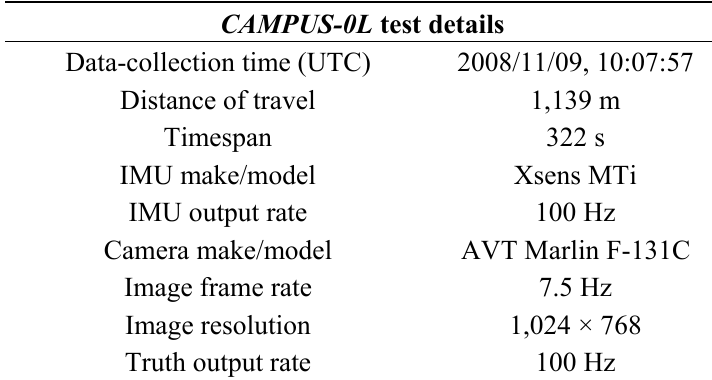
Table 1. Basic information of the live drive test (Reproduced with permission from [13]).